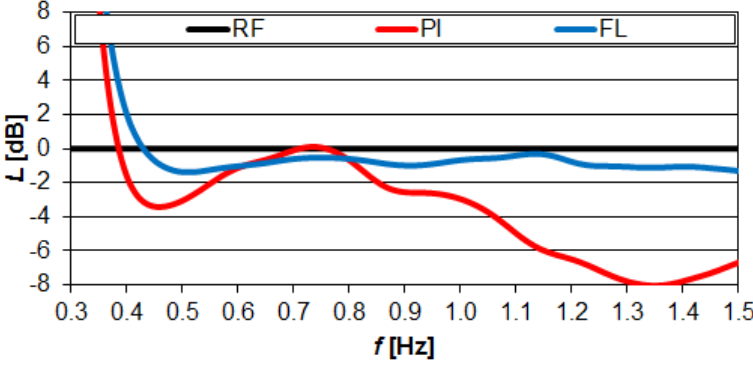
Figure 17. The amplitude-frequency characteristics of the energy transformation process carried out with the FL controller versus the PI controllers for the desired reference RF —the Pierson-Moskowitz spectra for 5th state of sea in North Atlantic for model scale equal to